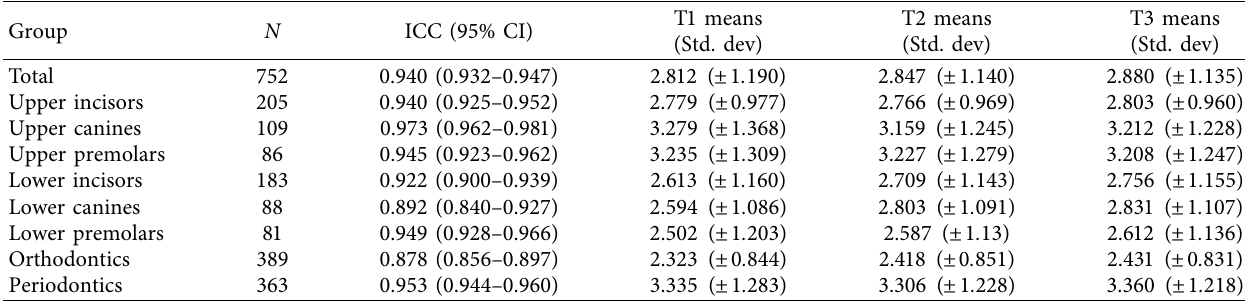
Table 2: Intrarater ABC-CEJ by tooth groups and clinic groups.